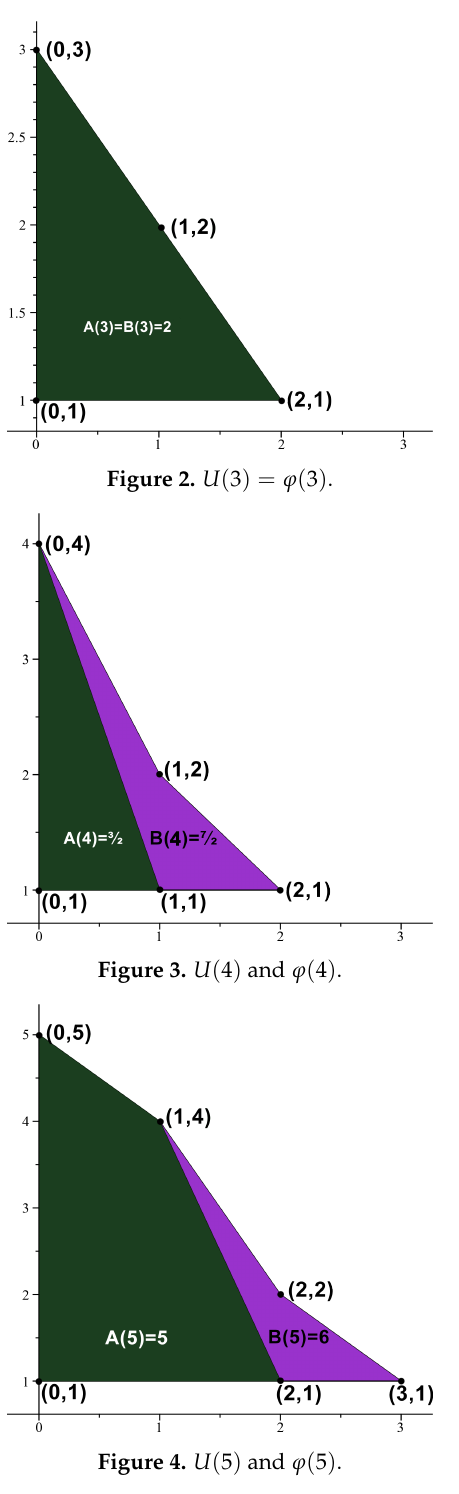
Figure 2. U ( 3 ) = ϕ ( 3 ) .